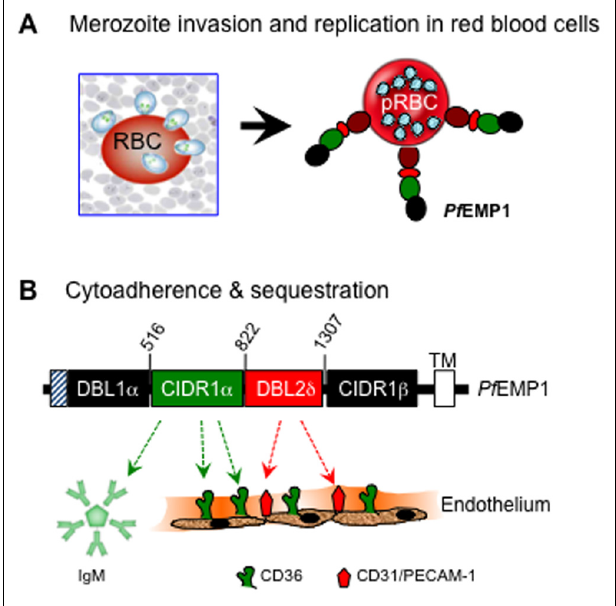
FIGURE 1 | Basic interactions of P. falciparum with human erythrocytes during invasion (A) and with blood capillary endothelium during cyto-adherence (B). Upon exit from the liver, invasion of red blood cells by the blood-stage merozoites leads to replication and subsequent surface expression of the multi-domain Pf EMP-1 molecule that mediates cyto-adherence via the binding activities of DBL1, CIDR1, and DBL2 domains of Pf EMP-1 with various host adhesion receptors. Shown here is a region of Pf EMP-1 encoded by FCR3S1.2- var1 (Chen etal., 2000).The CIDR1 domain primarily binds to CD36 and to members of the immunoglobulin superfamily, including IgM and CD31/PECAM (platelet endothelial cell adhesion molecule), whereas the DBL2 domain binds mainly to